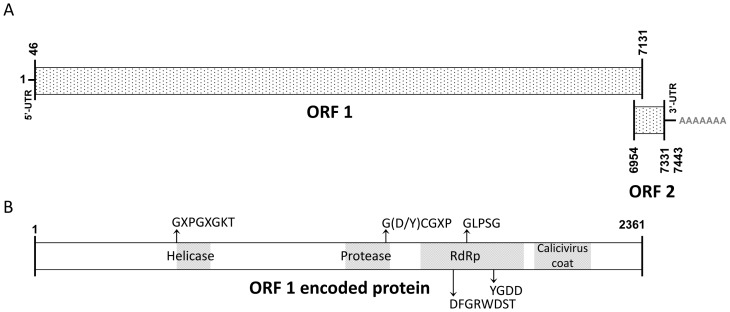
Genome organization of ASCV.A) The genome includes two ORFs. The predicted ORF1 spans almost the complete genome (numbers define nucleotide of start/end of ORF's and genome). A predicted small ORF2 is included in the 3′ end of the genome. B) Translated ORF1 amino acid sequence (numbers define amino acids of start/end of ORF1) includes several motifs that are conserved in calicivirus (positions indicated by arrows) and conserved protein domains (grey shading). The two ORFs and conserved amino acid motifs and domains confirm that the ORFs and predicted encoded non-structural proteins and capsid of ASCV are organized in an equal order as for the other caliciviruses.